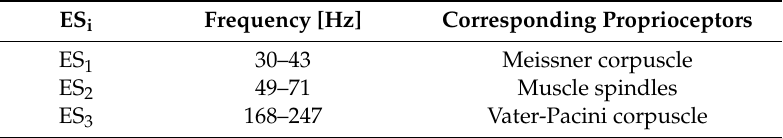
Table 2. Lists of names of each ES, frequency of vibration stimulus and corresponding proprioceptors. ES i Frequency [Hz] Corresponding Proprioceptors ES 1 30–43 Meissner corpuscle ES 2 49–71 Muscle spindles ES 3 168–247 Vater-Pacini corpuscle ES: Evaluation